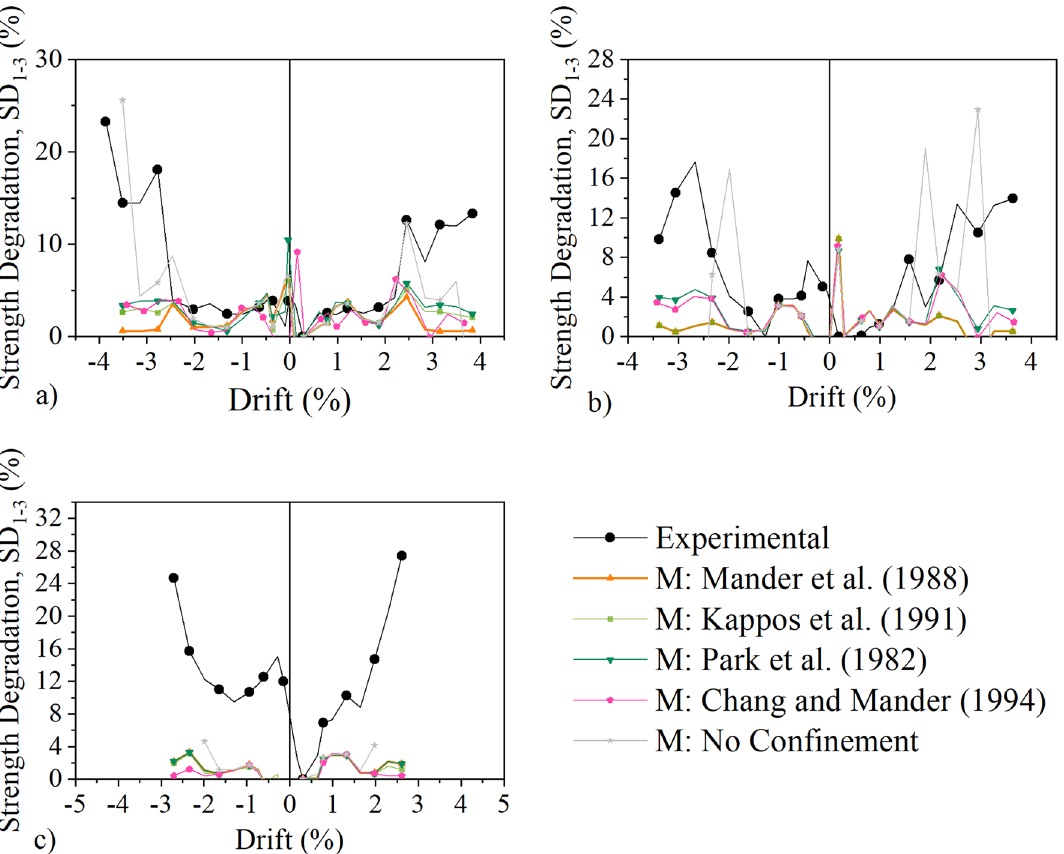
Figure 13. Strength Degradation between 1st and 3rd cycle: ( a ) column C, ( b ) column M, ( c ) column